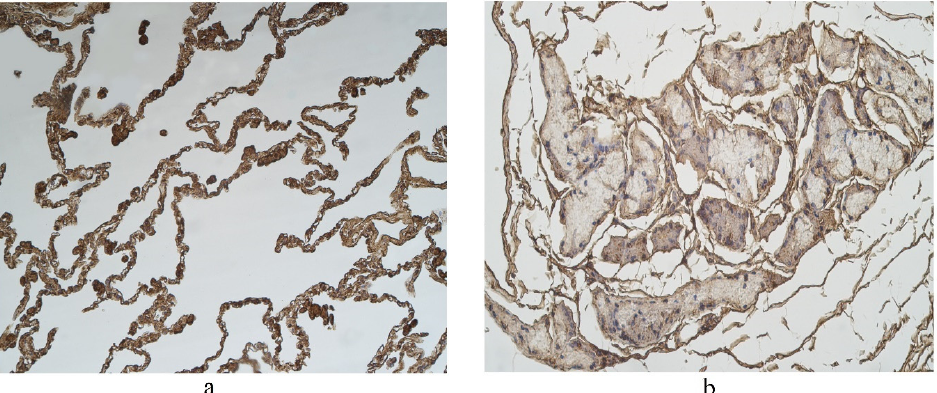
Figure 4. Immunohistochemical micrographs in lung tissue samples. ( a ) Note moderate number of IL-17A immunoreactive cells in the alveolar epithelium and numerous alveolar macrophages of 56-year-old male. IL-17A IMH, ×200; ( b ) a few IL-17A positive structures are observed in glands of 25-year-old male. IL-17A IMH, ×250.